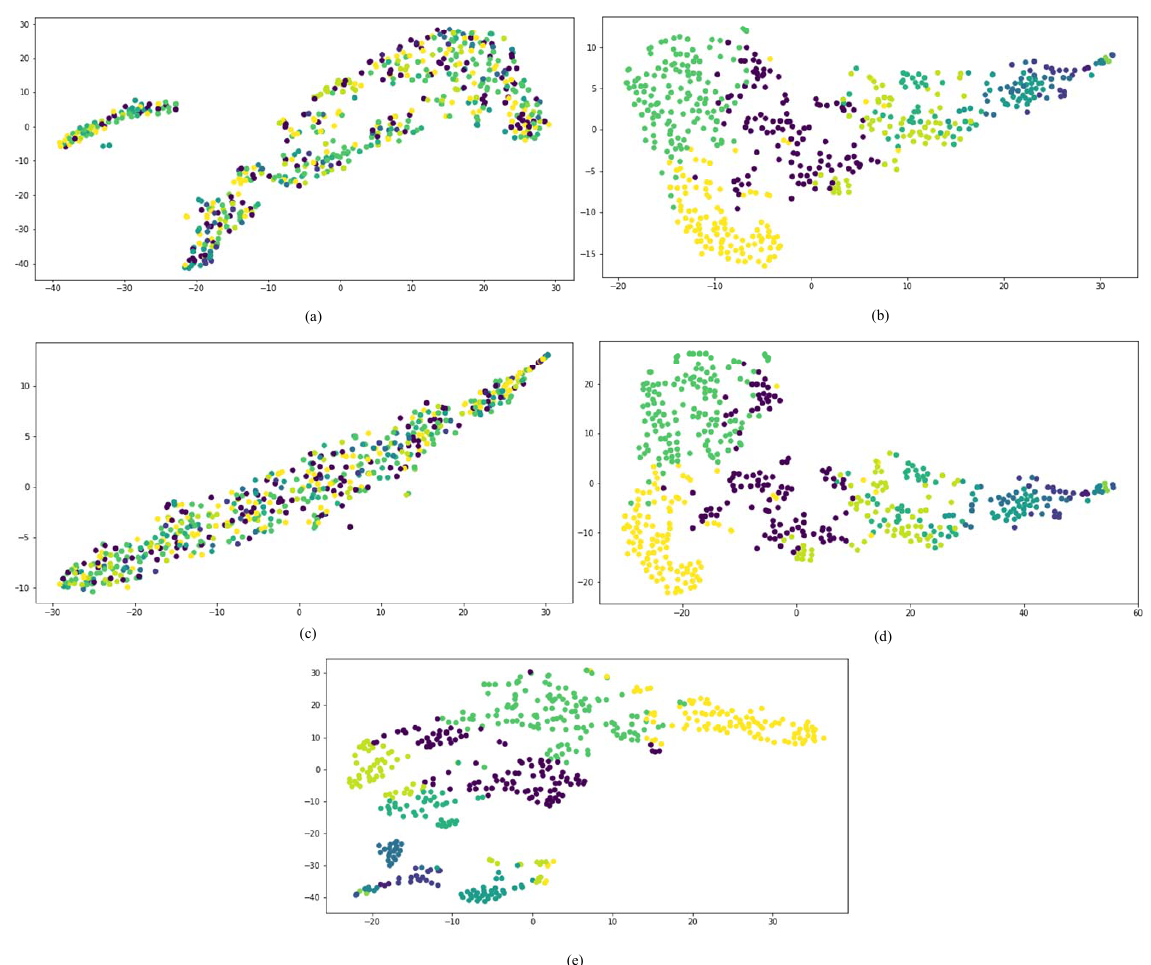
Figure 6. Visualization of the different representations: ( a ) concatenate drug features; ( b ) GraphCNN; ( c ) metapath2vec++ ; ( d ) SDHINE-no-target propagation; ( e )